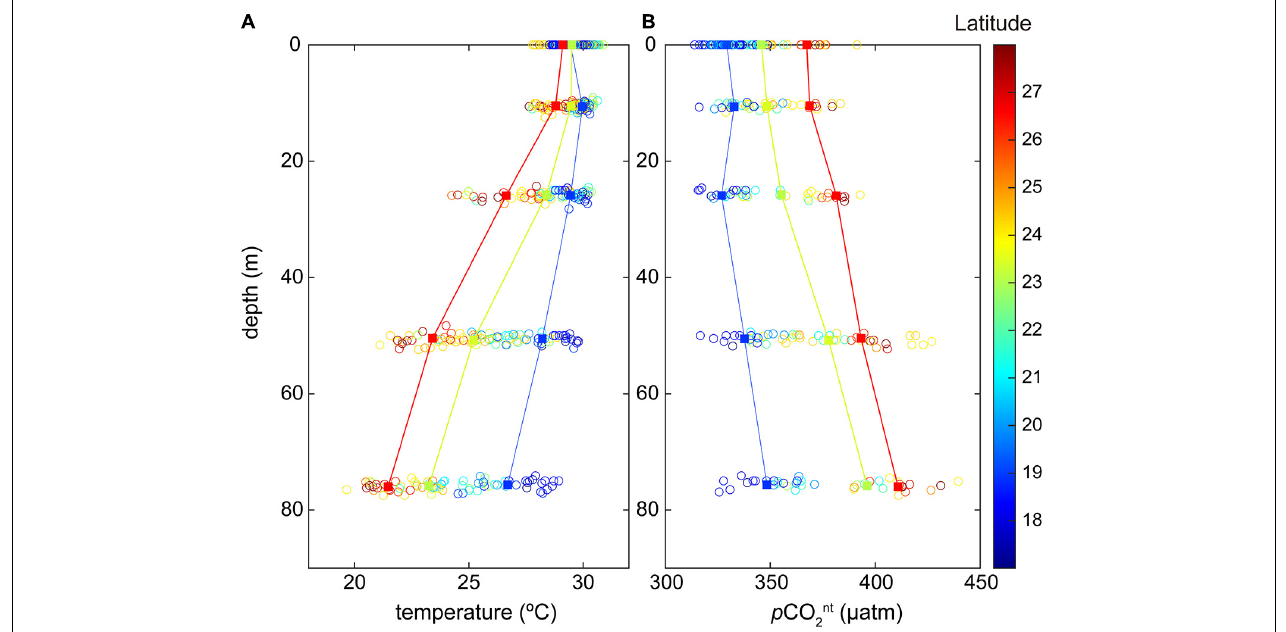
FIGURE 6 | The vertical distributions of (A) temperature ( ◦ C) and (B) p CO 2 nt ( µ atm) calculated using dissolved inorganic carbon (C T ) and total alkalinity (A T ) data obtained from the GLODAP v2 dataset (Olsen et al., 2016). Solid lines indicate the mean values for each depth of different latitudinal bands and color shading represents the